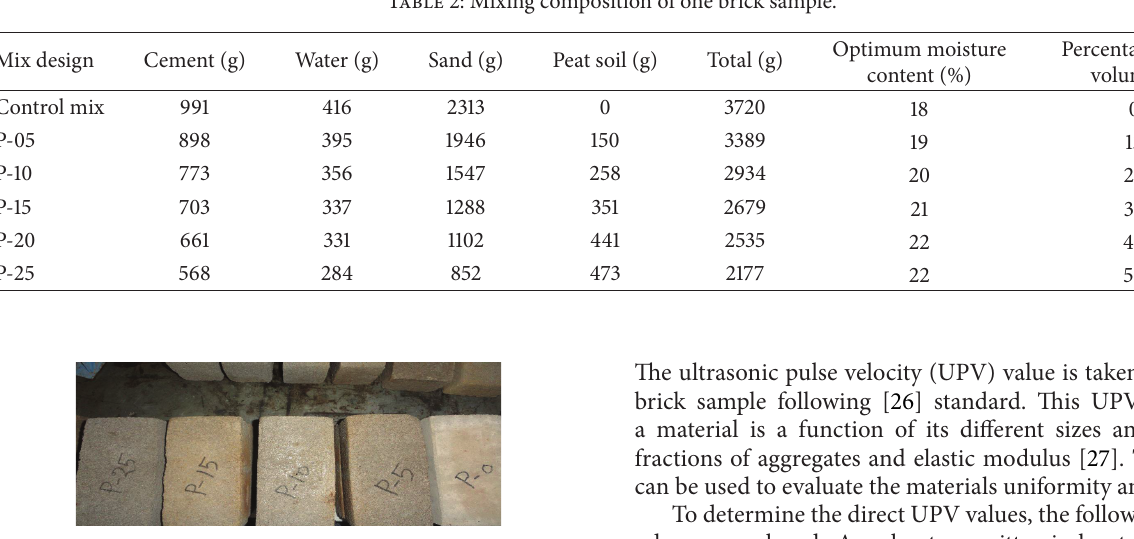
Table 2: Mixing composition of one brick sample.